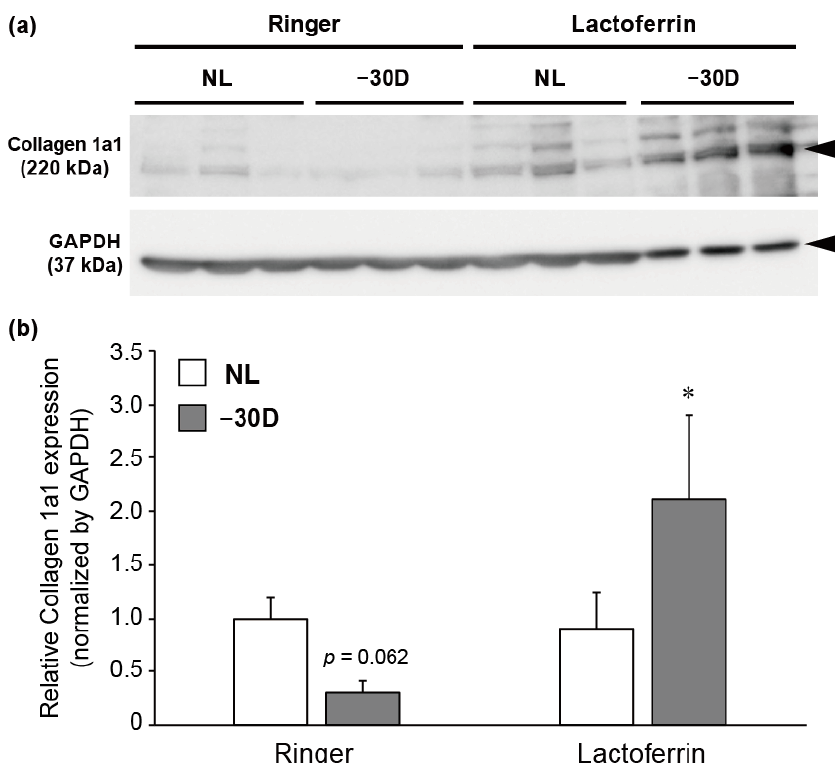
Figure 4. LIM decreased collagen 1A1 expression and oral administration of LF reversed its effect. ( a ) Immunoblotting showed a decrease in collagen 1A1 expression in the right eye in the control group; this decrease was absent in the LF group. ( b ) The densitometry quantitation of blots: the Ringer’s–NL group was assigned a value of 1.0; all other values are expressed relative to this value; * p < 0.05.